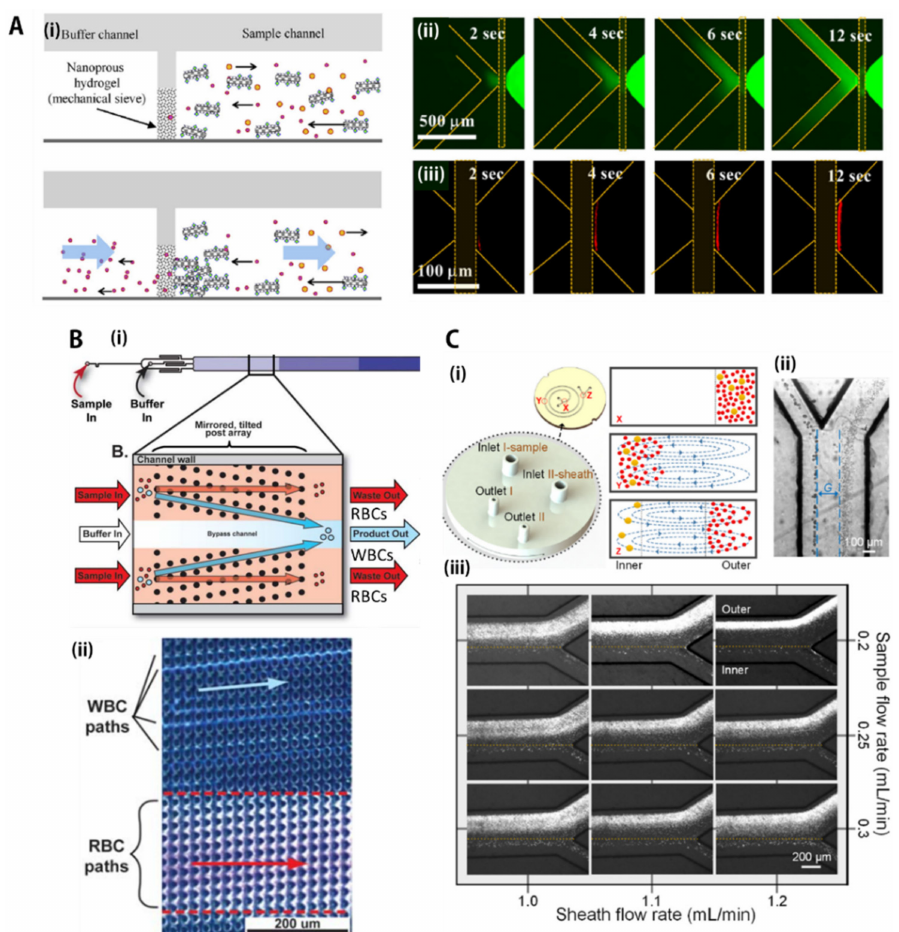
Figure 2. Microfluidic passive-force separation group 1: hydrodynamic, flow-based separation. ( A ) Size-based particle filtration using nanoporous hydrogel membranes as a sieving structure within microchannels. ( i ) Schematic description for showing the operational principle of the size- based filtration. ( ii , iii ) Experimental results of the separation. ( ii ) Non-target proteins with green fluorescence ( ii ) penetrated the hydrogel membrane, ( iii ) while red-fluorescent target biomolecules bound to long-molecular carriers (microtubules, >10 µ m in length) were selectively filtered by the nanoporous membrane. Reprinted with permission from Elsevier B.V. [62]; ( B ) ( i ) Separation principle of deterministic lateral displacement (DLD)-based blood cell separation. ( ii ) Experimental results of blood separation using DLD device. Relatively large white blood cells moved to buffer channel, while smaller cells, such as red blood cells and platelets, remained in sample channel. Reprinted with permission from John Wiley & Sons, Inc. [65]; ( C ) ( i ) Operational principle of inertial separation in the syringe i-sorter. ( ii ) The separation of 7 µ m and 20 µ m particles at the outlet at the optimal flow rates of 0.2 mL/min and 1.2 mL/min for the sample flow and sheath flow, respectively; ( iii ) Distributions of tumor and blood cells at the outlet at varied flow rates. At all the tested flow rates, the tumor cells were focused near the inner channel wall (below the yellow dotted line), while the blood cells formed a relatively large band with varied widths near the outer channel wall. Reprinted with permission from Elsevier B.V. [66]. All rights